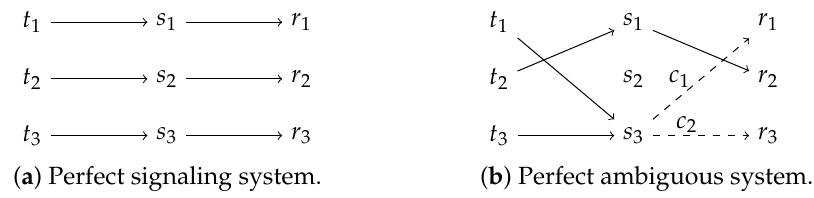
Figure 2. A perfect signaling system of the CS game is shown in ( a ), and a perfect ambiguous system of the CS game is shown in ( b ). Both achieve an expected utility of